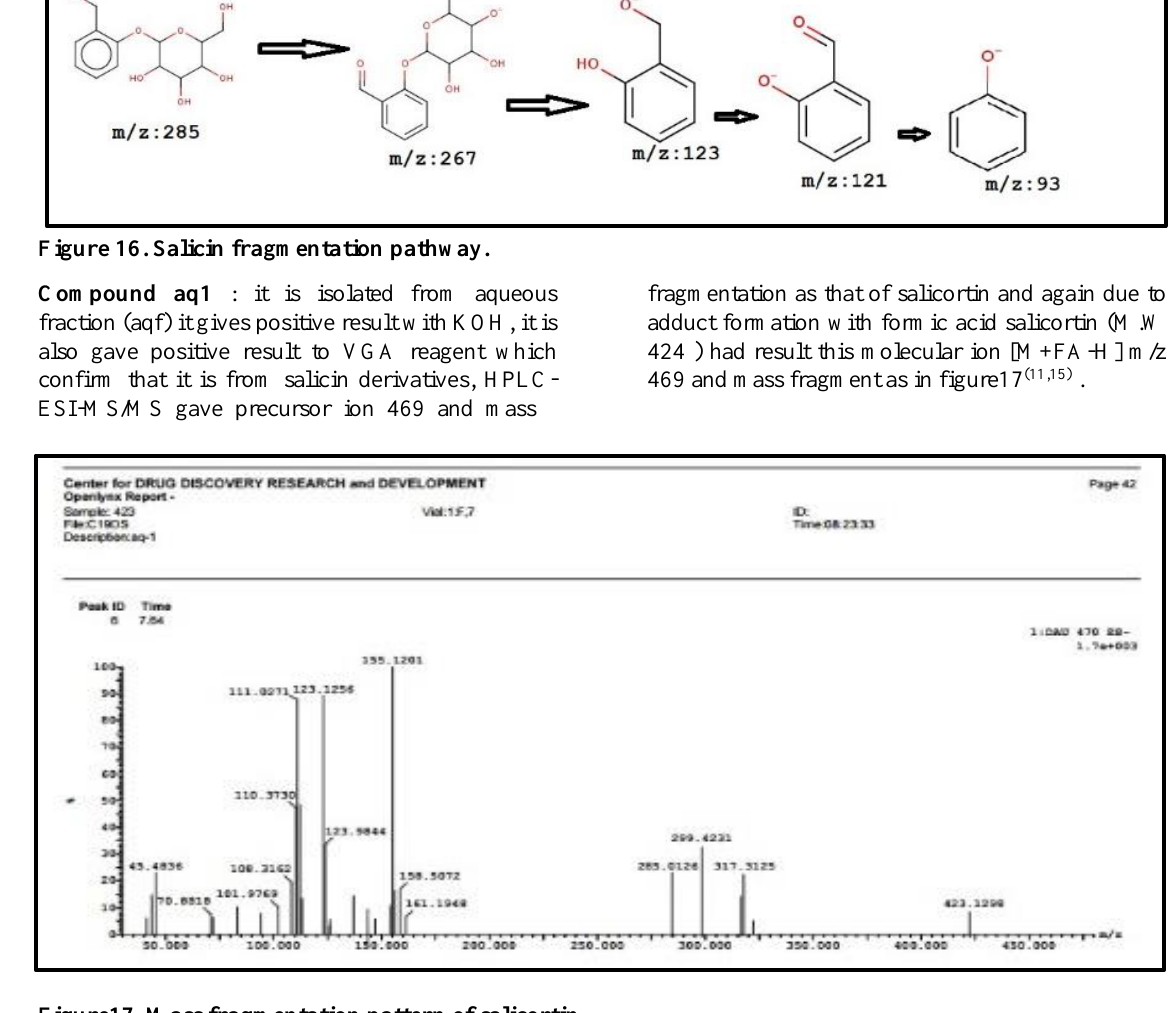
Figure17 .Mass fragmentation pattern of salicortin.